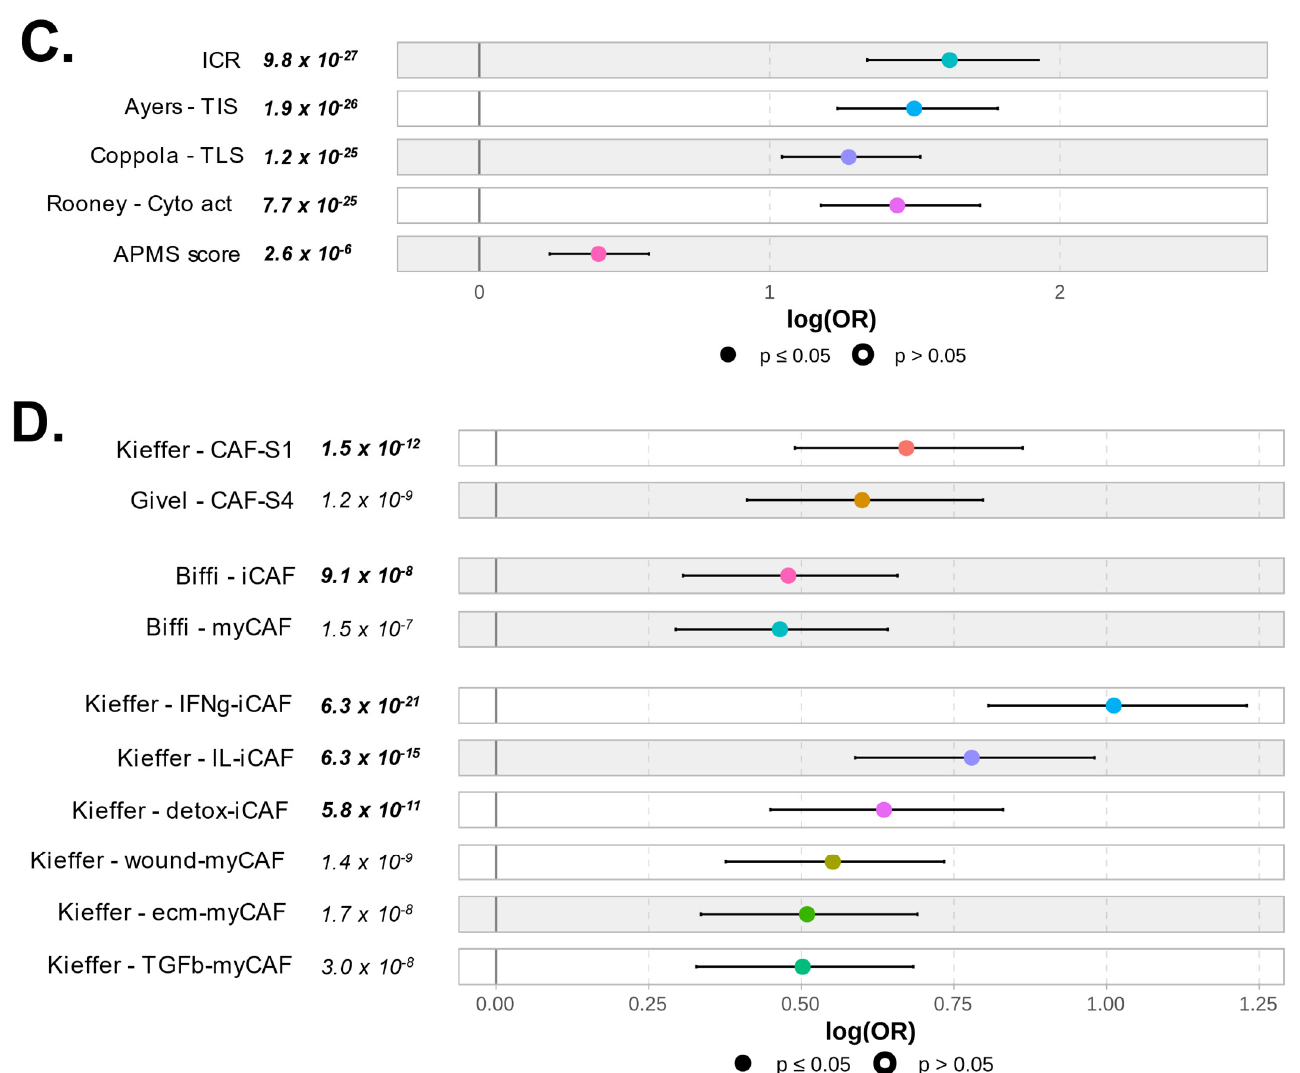
Figure 6. Correlation of PVRIG expression levels with immune and stromal features: ( A ) Forest plot representation of the correlations between PVRIG Low ( left ) and High ( right ) expression and the TILs score tool. ( B ) Forest plot representation of the correlations between PVRIG Low (left from the 0 value) and High (right from the 0 value) expression and the Bindea’s immunome (24 immune populations). ( C ) Forest plot representation of the correlations between PVRIG Low ( left ) and High ( right ) expression and immune functional signatures, including ICR, TIS, and TLS enrichment signatures, the immune cytolytic activity score, and the APM signature. ( D ) Forest plot representation of the correlations between PVRIG Low ( left ) and High ( right ) expression and CAFs subsets. The p -values are for the logit link test.